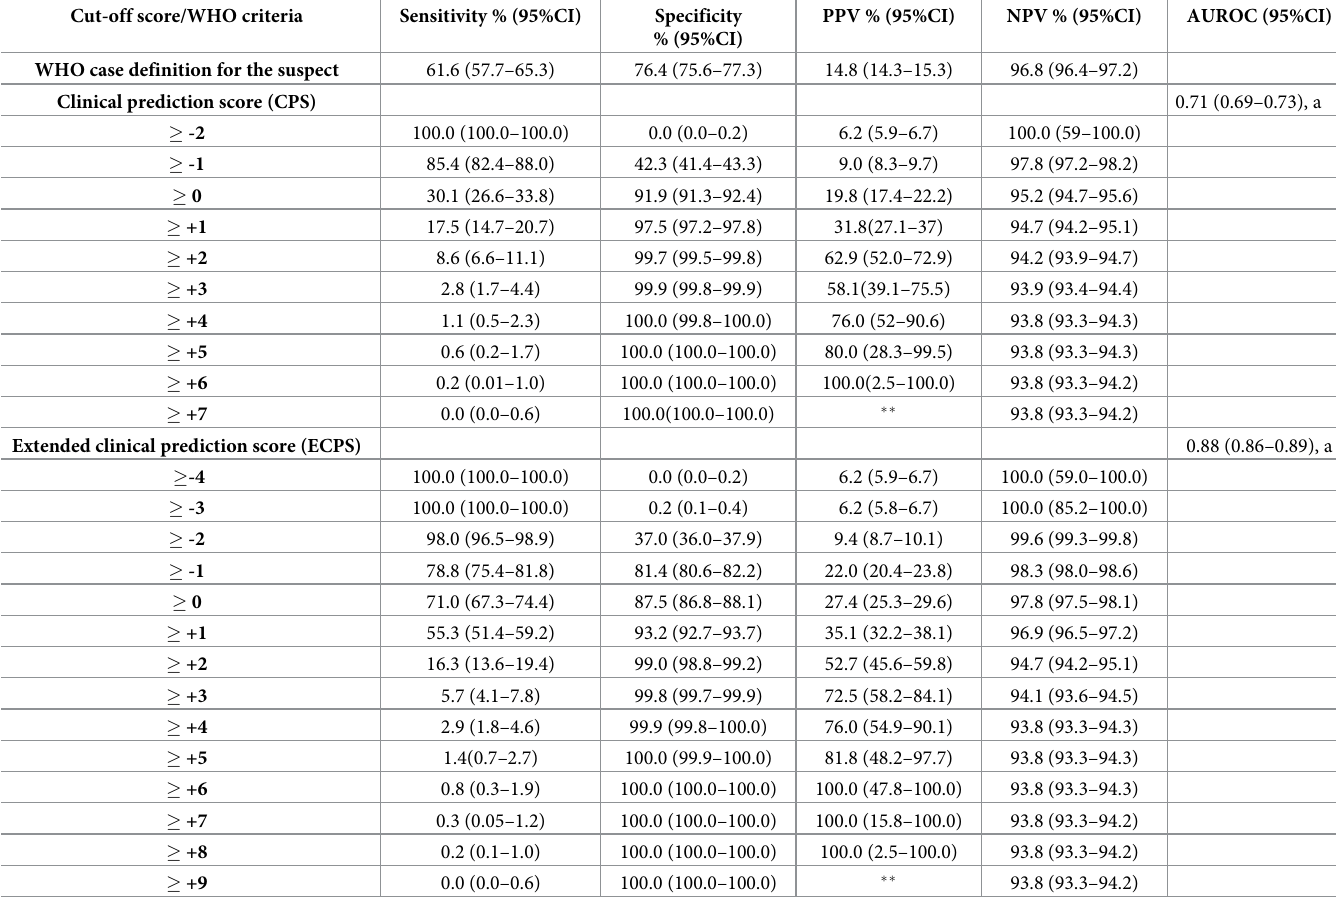
Table 4. Diagnostic performance at cut-points of total score for predicting EVD of clinical prediction score, extended clinical prediction score, and the WHO crite- ria for suspects. Cut-off score/WHO